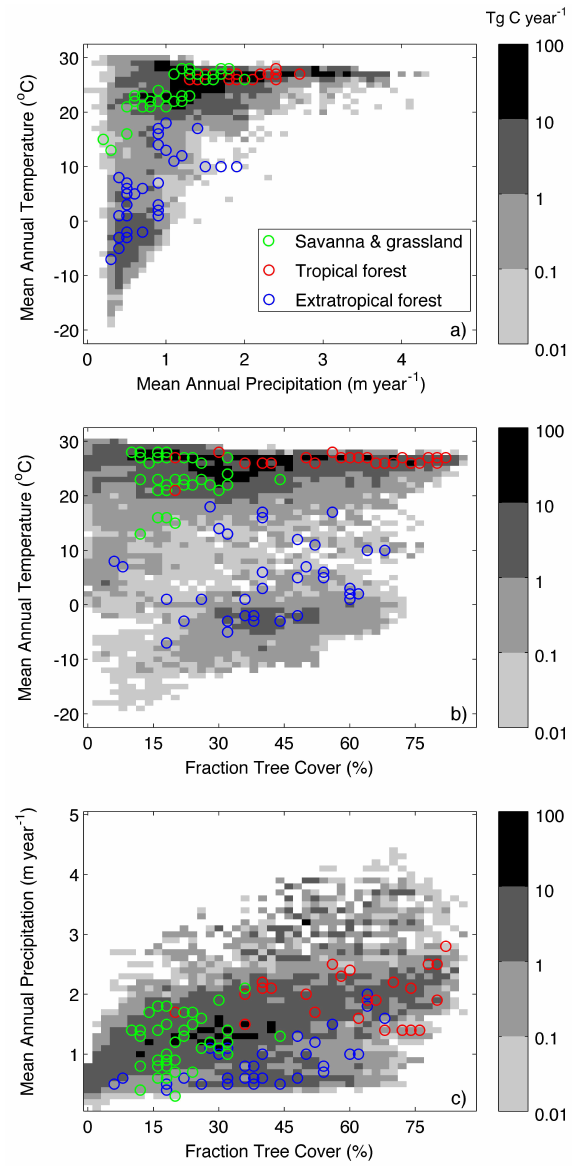
Fig. 5. GFED3.1 fire emissions in TgCyear − 1 (mean for 1997– 2008) in a temperature versus precipitation (a) , temperature versus FTC (b) , and precipitation versus FTC (c) window overlain by EF measurements in the savanna and grassland (green), tropical for- est (red), and extratropical forest (blue circles) biome. Temperature and precipitation were averaged over